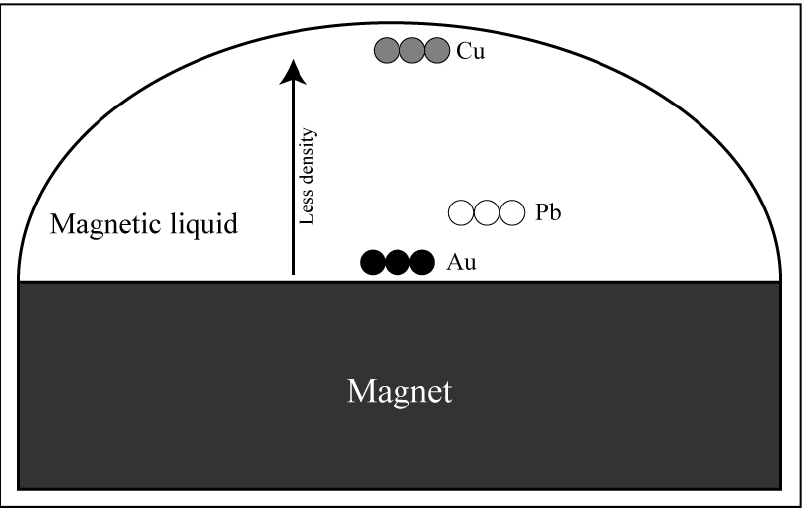
Figure 2. Principle of magnetic density separation, redrawn from [74].